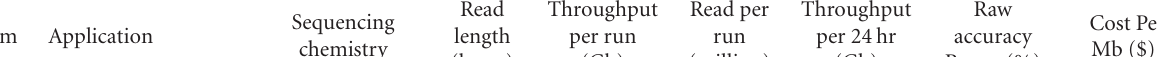
Table 2: Comparison of major next generation DNA sequencing technologies and conventional